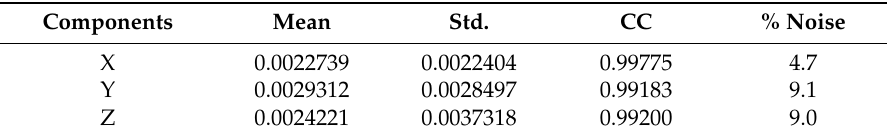
Table 2. Statistical mean and standard deviation (Std.) values of the RMS differences in m/s 2 between the WCF kinematic accelerations for receivers A and B in Figure 7. The correlation coefficients (CC(A,B)) between the datasets of the two receivers is also listed along with the related % noise contributions from Equation